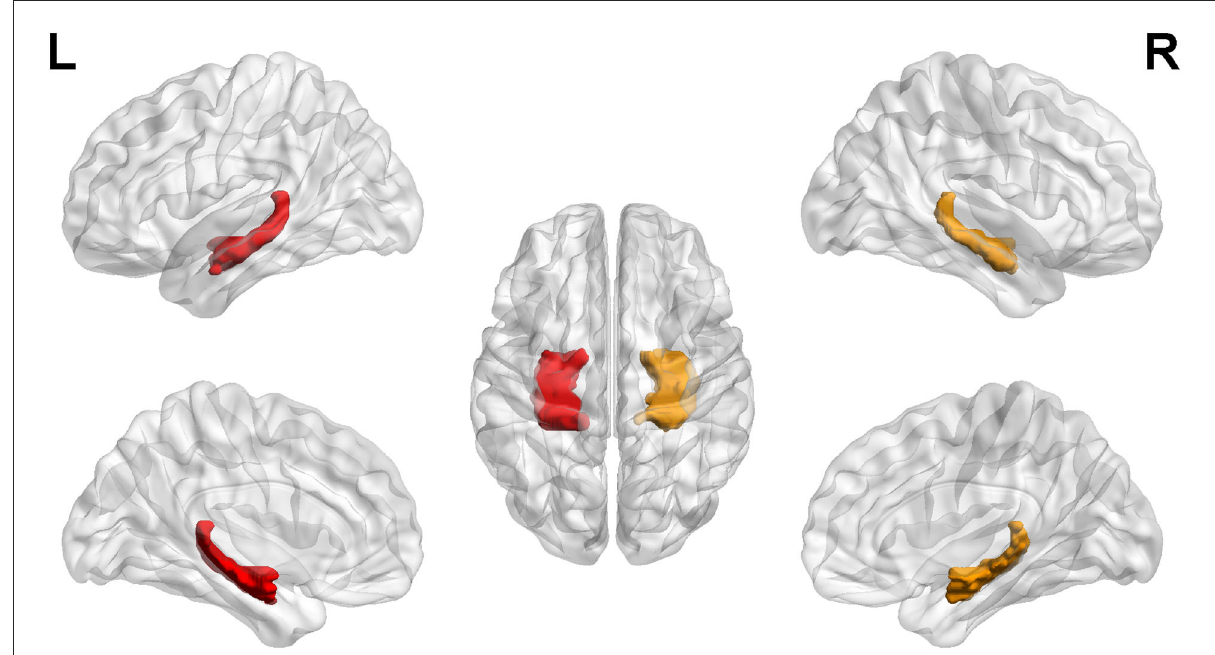
FIGURE1 Regions of interest. The left hippocampus and right hippocampus labeling with color. L, left; R, right.